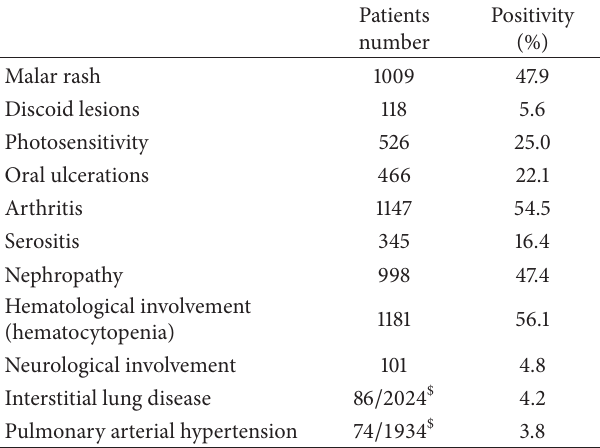
Table 3: The profile of clinical manifestations in 2104 SLE patients from CSTAR cohort